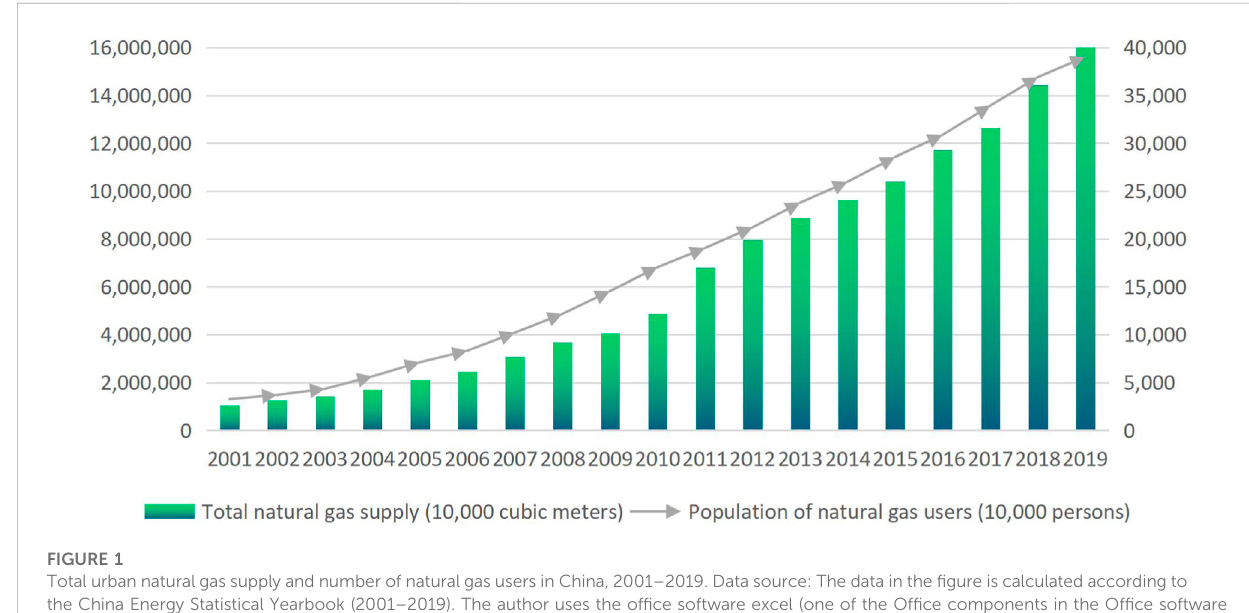
FIGURE 1 Total urban natural gas supply and number of natural gas users in China, 2001 – 2019. Data source: The data in the fi gure is calculated according to the China Energy Statistical Yearbook (2001 – 2019). The author uses the of fi ce software excel (one of the Of fi ce components in the Of fi ce software package developed by Microsoft in United States) to draw.